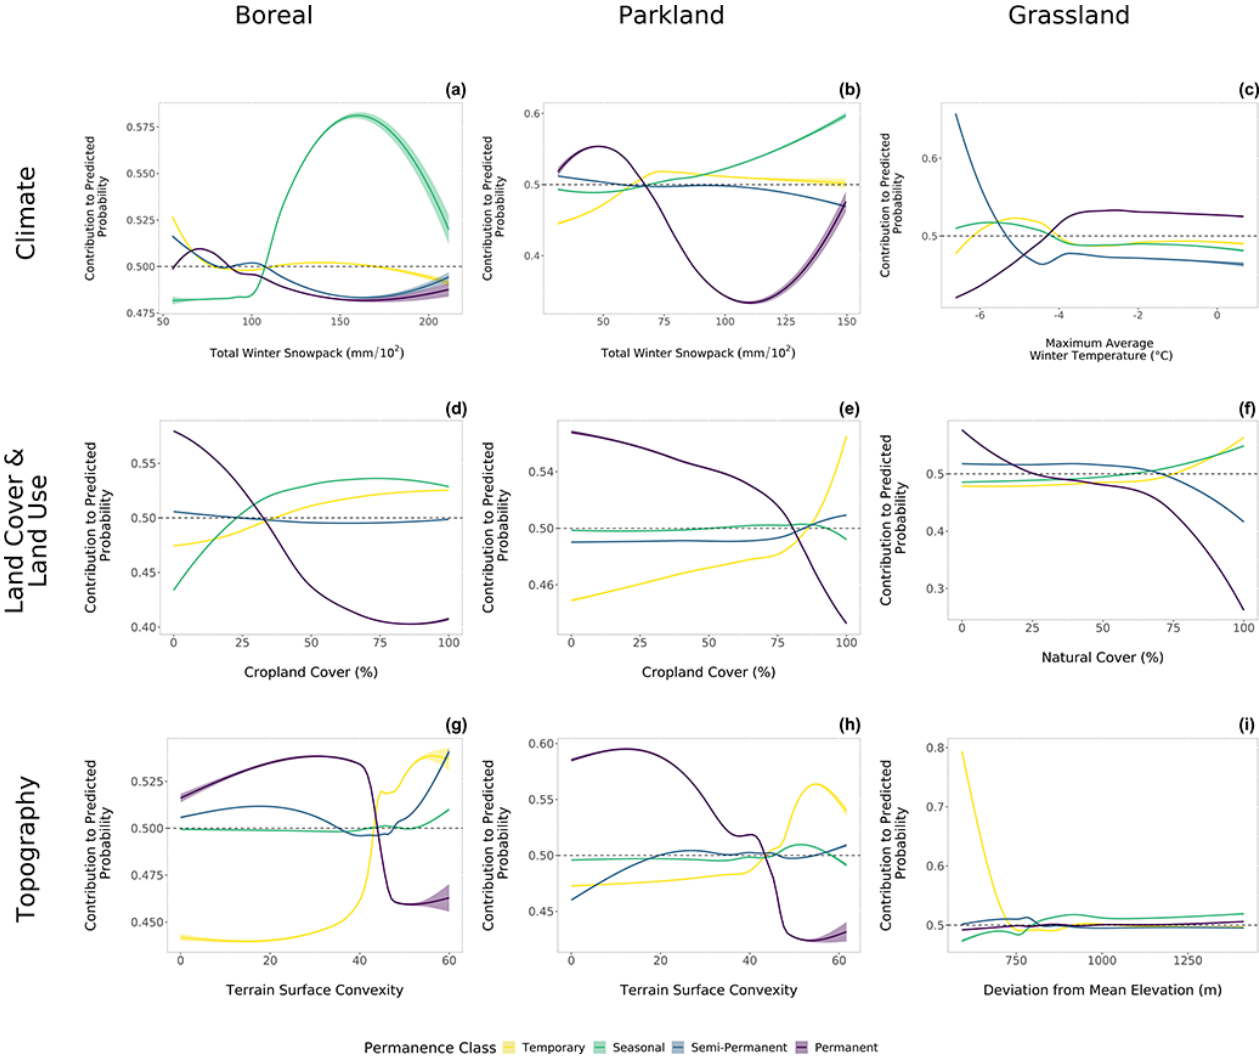
Figure 5. Partial dependence plots for the four wetland classes – temporary, seasonal, semi-permanent and permanent based on top metrics. Predicted probabilities below 0.5 suggest that at this measured value of the metric observing that permanence class is unlikely. We show 95% confidence intervals and used a generalized additive model-based trend line. Probabilities were derived from extreme gradient boosting models for wetlands delineated in the (1) Boreal Forest (totalling 12000 wetlands), (2) Parkland (totalling 12000 wetlands) and (3) Grassland (totalling 16000 wetlands) natural